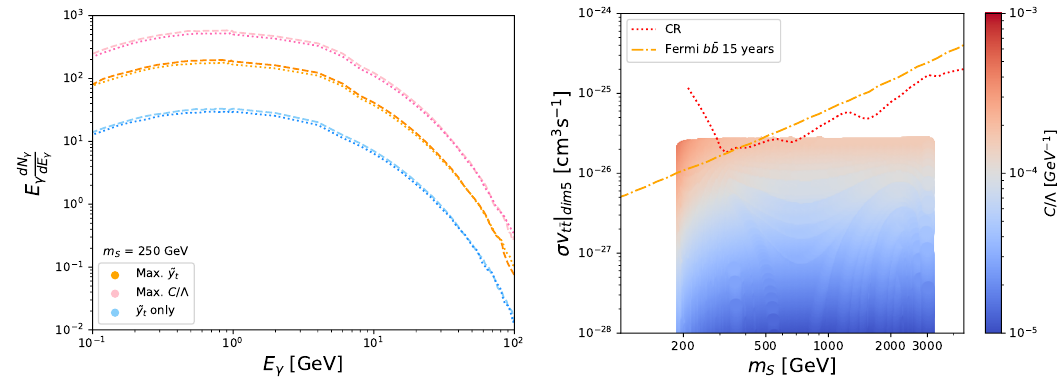
Figure 6 . Left — Photon spectra resulting from SS → t ¯ t (dashed line) and SS → b ¯ b (dotted line) annihilations, for a dark matter benchmark mass m S = 250 GeV . The lines correspond to parameter choices for which the DM relic density is correctly reproduced while C/ Λ is maximal (pink), ˜ y t is maximal (orange), or C/ Λ = 0 (blue). Right — Contribution to the SS → tt annihilation cross section at zero velocity (as a function of m S ) due to the inclusion of the dimension-five contact interaction. The colour scale indicates the value of C/ Λ required to obtain the observed relic density. Also shown are bounds due to cosmic rays [37] (dotted red), and projected bounds